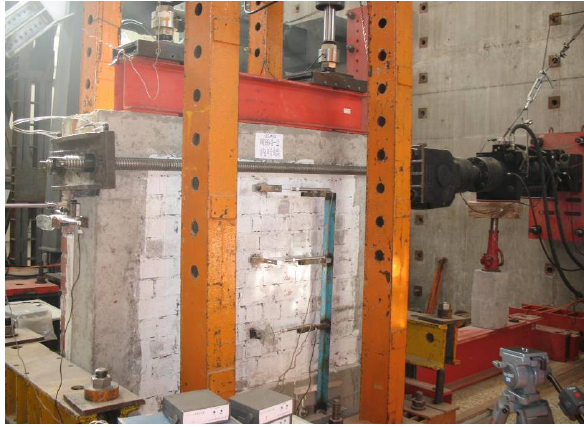
Figure 4. Photograph of testing setup.